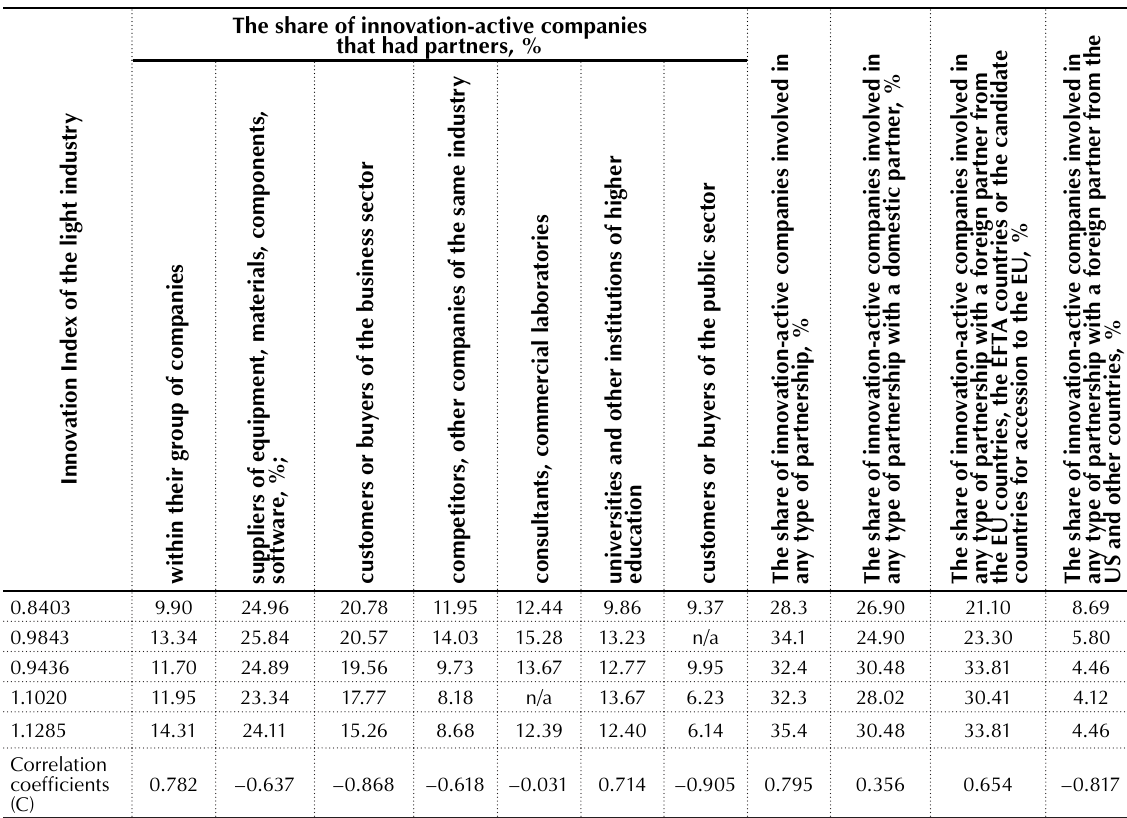
Table 6. The values of correlation coefficients between the indicators of network innovative cooperation and the innovation index of light industry of the EU countries Source: Calculated according to the data of Tables 4 and